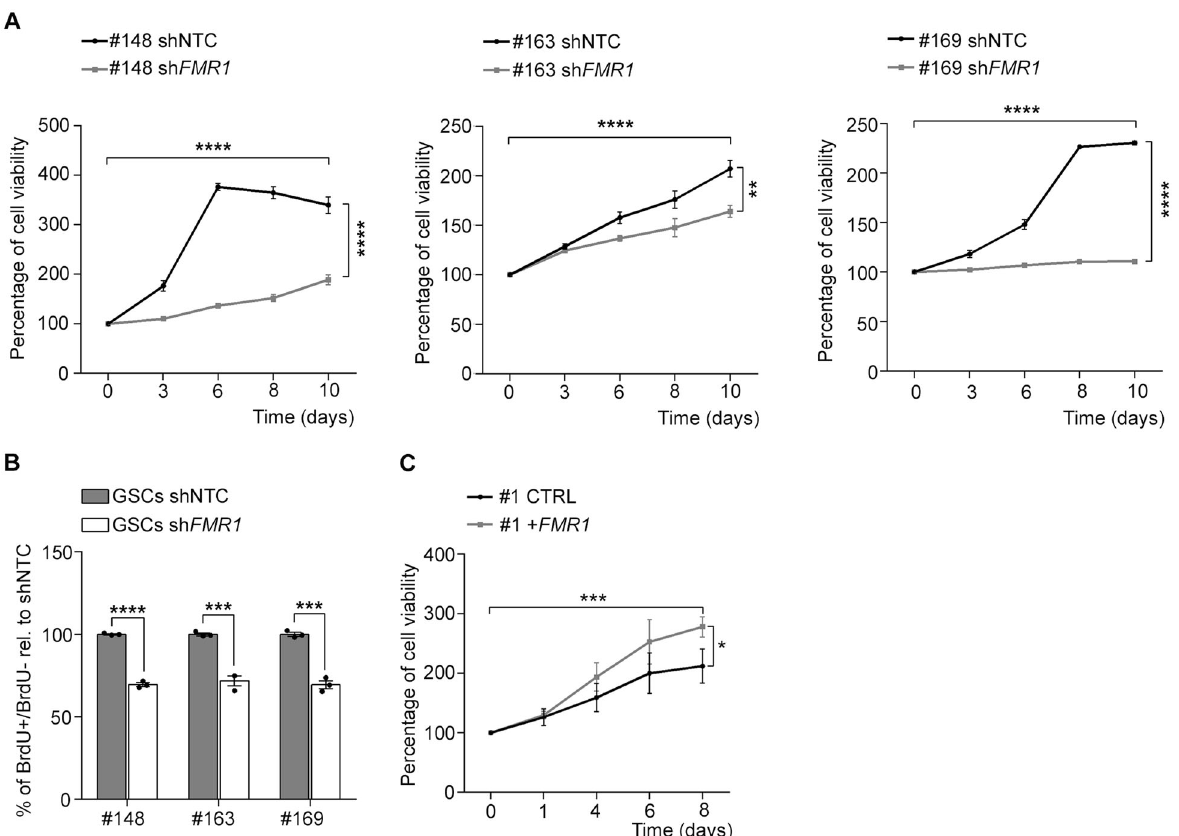
Fig. 3 Reduction of FMRP impairs proliferation of GSCs. A Growth curves of GSCs transduced with either shNTC or sh FMR1 (as indicated on top of each graph). The percentage of cell viability is plotted against days in culture (mean ± SEM, n = 3, two-way ANOVA). B The percentage of BrdU incorporation in the sh FMR1 compared to shNTC GSCs (mean ± SEM, n = 3, *** P < 0.001, Student ’ s t -test). C Growth curves of GSC#1 transduced with the empty vector (CTRL) or with the vector overexpressing FMRP ( + FMR 1). The percentage of cell viability is plotted against days in culture (mean ± SEM, n = 3, * P < 0.05, *** P < 0.001, two-way